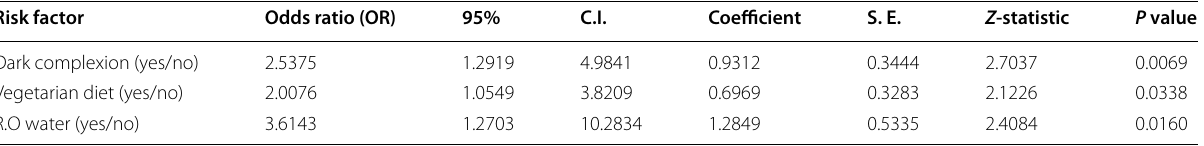
Table 3 Multivariate analysis of risk factors affecting vitamin B12 deficiency Risk factor Odds ratio (OR) 95% C.I. Coefficient S. E. Z -statistic P value Dark complexion (yes/no) Vegetarian diet